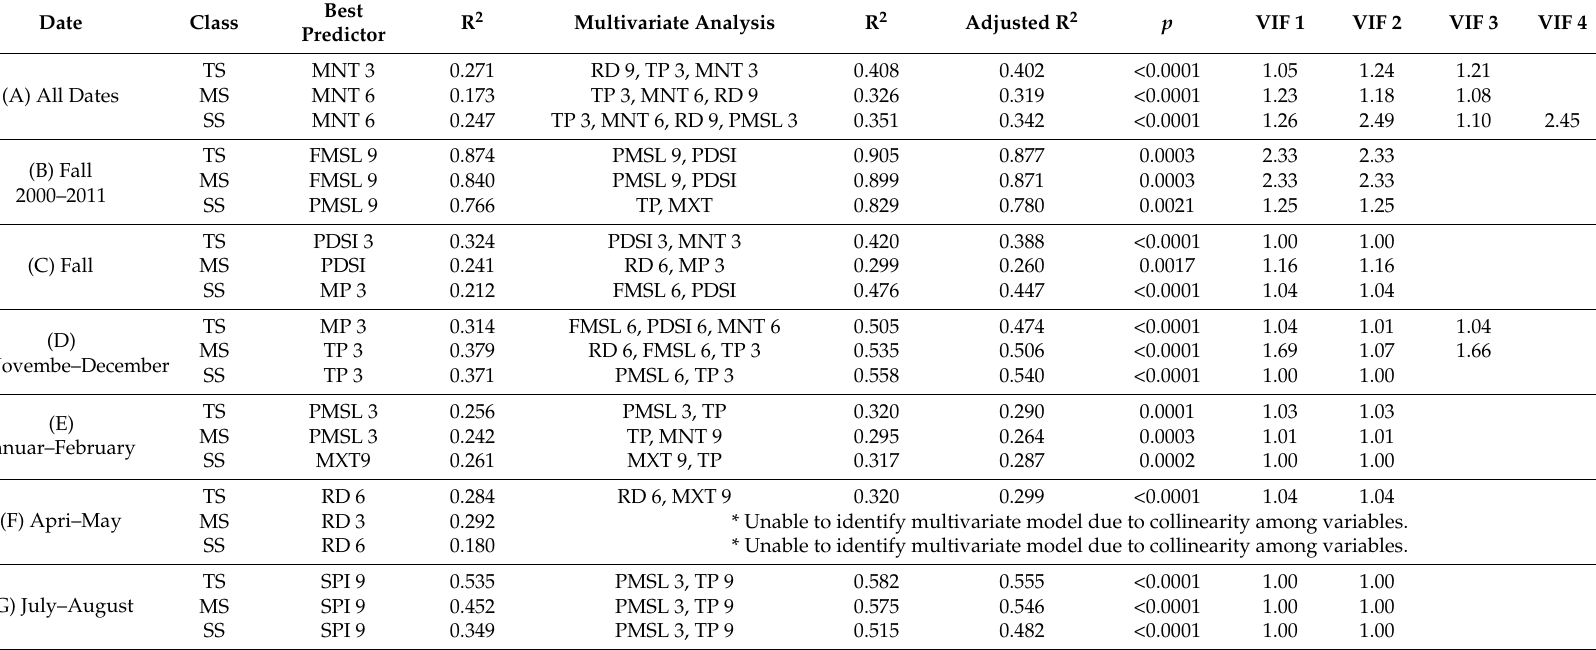
Table 6. Best univariate and multivariate regression model abiotic drivers for predicting S. alterniflora biomass for each size class, Tall (TS), Medium (MS), and Short (SS): (A) all dates ( n = 294) from 1984 to 2011, (B) between the last week of September through the first week of November ( n = 10) from 2000 to 2011; (C) between the last week of September through the first week of November ( n = 39) from 1984 to 2011; (D) within November and December ( n = 52), (E) within January and February ( n = 49), (F) within April and May ( n = 69), and (G) within July and August ( n = 33). Note that all single and multivariate analyses were positive relationships and the four bimonthly-binned periods used the entire 1984–2011 observation